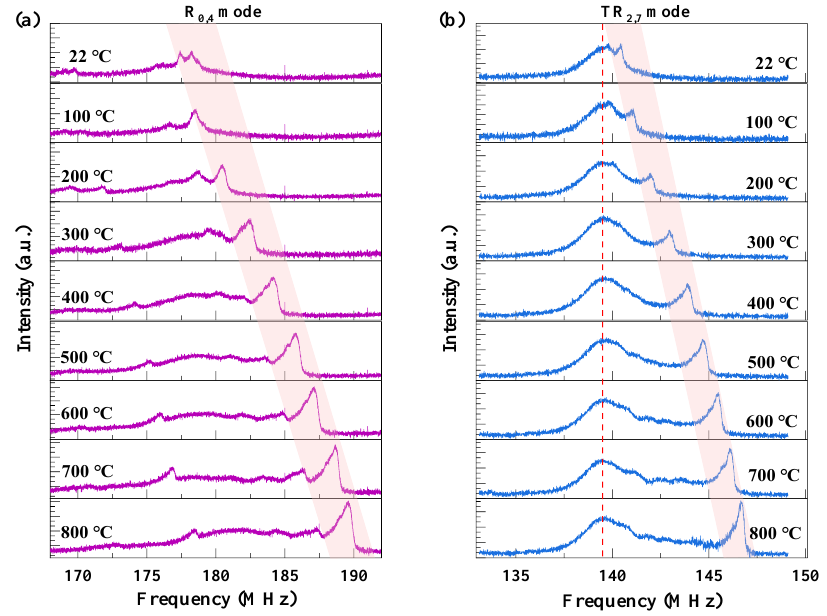
Figure 3. Measured ( a ) R 0,4 mode induced polarized GAWBS spectrum, and ( b ) TR 2,7 mode induced depolarized GAWBS spectra at temperatures ranging from 22 °C to 800 °C.